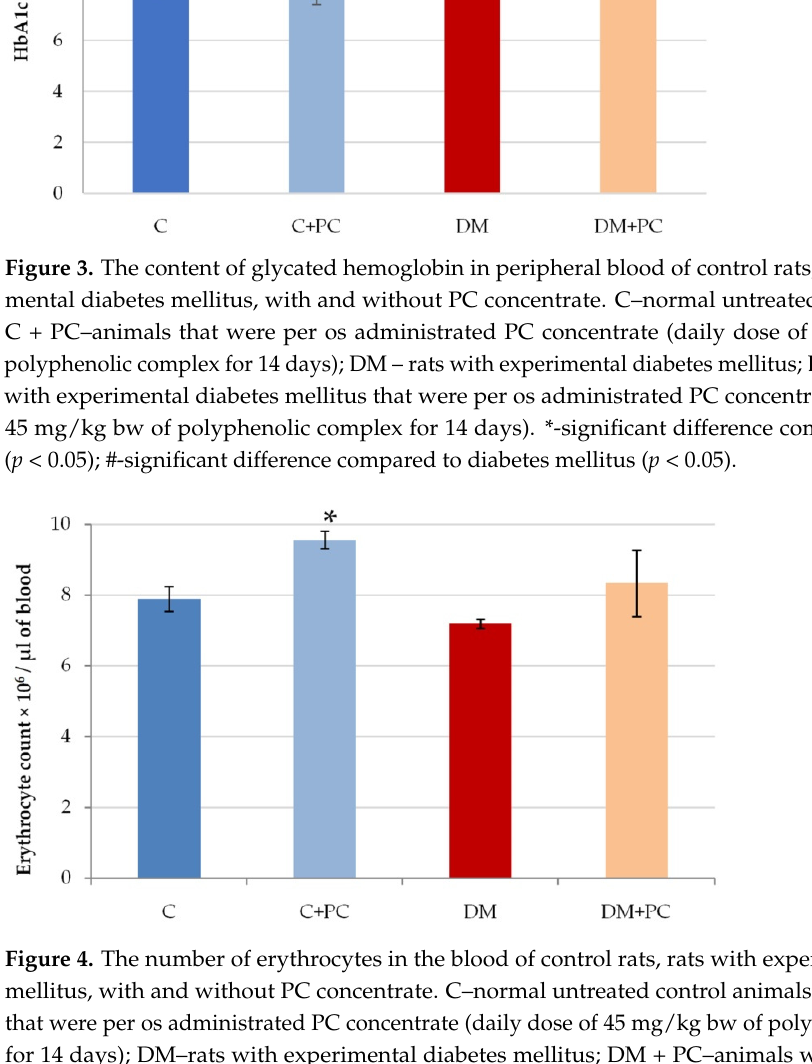
Figure 4. The number of erythrocytes in the blood of control rats, rats with experimental diabetes mellitus, with and without PC concentrate. C–normal untreated control animals; C + PC–animals that were per os administrated PC concentrate (daily dose of 45 mg/kg bw of polyphenolic complex for 14 days); DM–rats with experimental diabetes mellitus; DM + PC–animals with experimental diabetes mellitus that were per os administrated PC concentrate (daily dose of 45 mg/kg bw of polyphenolic complex for 14 days). *-significant difference compared to control ( p <